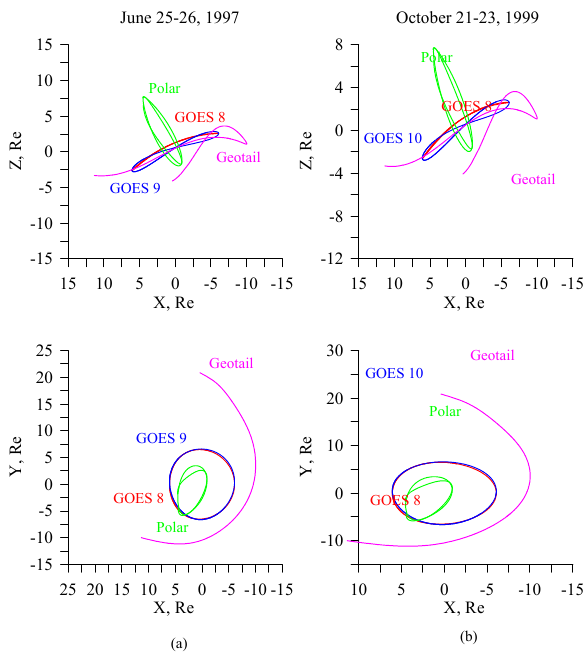
Fig. 2. Evolution of orbits of satellites during the time periods when the magnetic field data was used for modelling storm events on ( a ) 25–26 June 1997, and ( b ) 21–23 October 1999.